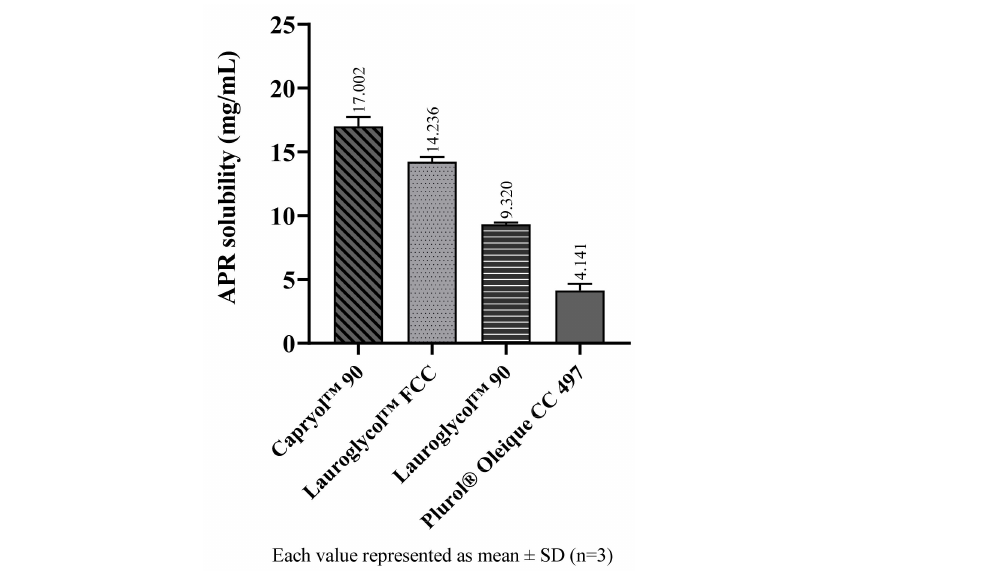
Figure 5. The solubility of APR at 25 ◦ C in